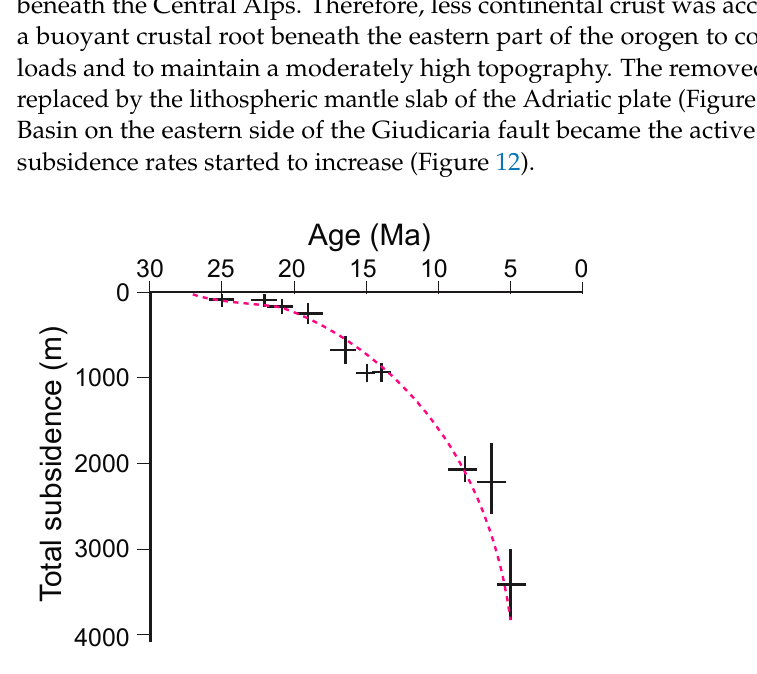
Figure 12. Evolution of the total subsidence of the Po basin recorded by sections that are exposed in the hangingwall of the Montello thrust (see site labelled with ‘P’ in Figure 2 for location). The subsidence pattern [133] has been corrected for eustatic sea level variations and compaction.